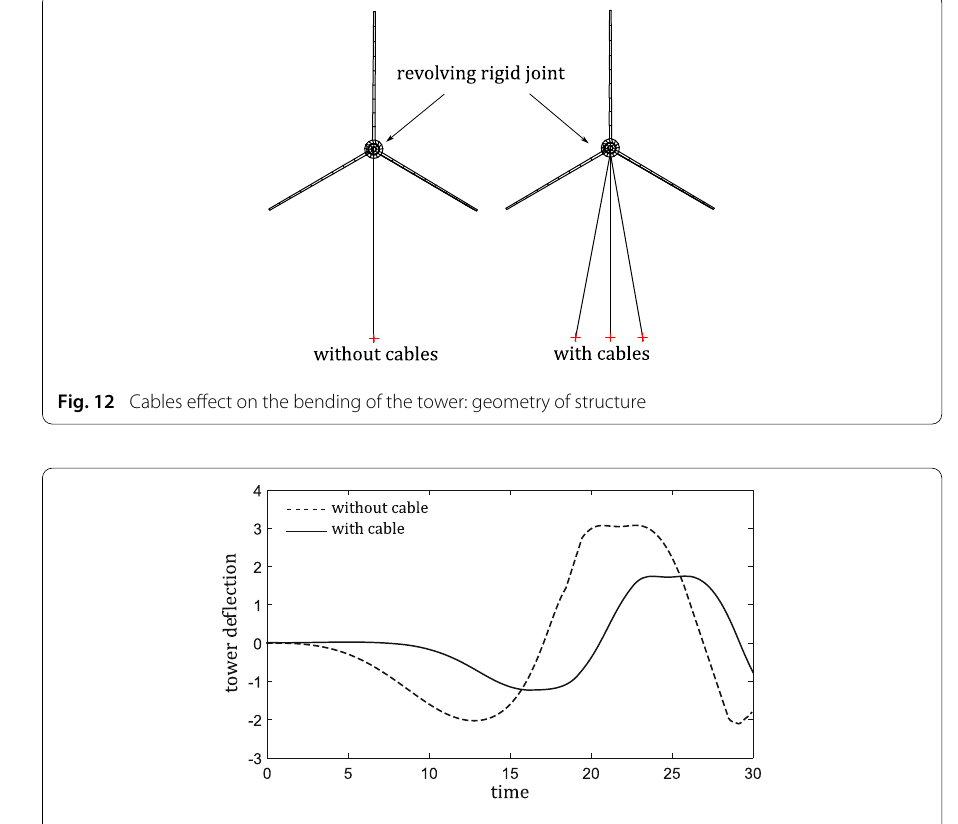
Fig. 13 Cables effect on the bending of the tower: horizontal displacement of the free end